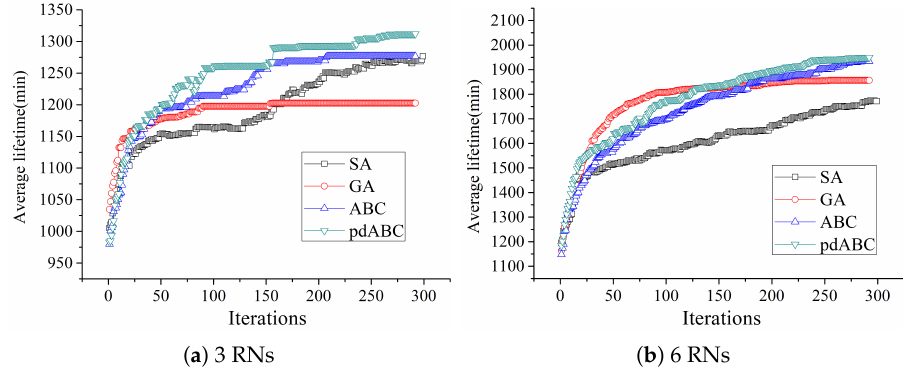
Figure 9. Lifetime optimization trend with different RN numbers in 100 × 100